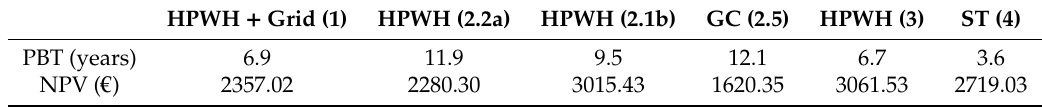
Table 6. Payback time and net present value (national incentive).